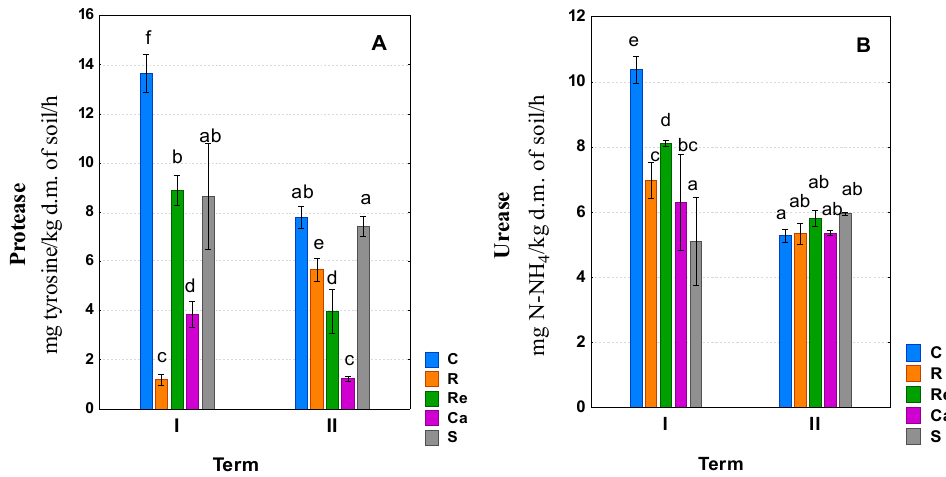
Figure 1. Enzymatic activity in the soil. Legend: ■ C-control (without pesticides), ■ R-herbicide Roundup, ■ Re-herbicide Reglone, ■ Ca-fungicide Caramba, ■ S-adjuvant Spodnam. A —Protease activity, B—Urease activity